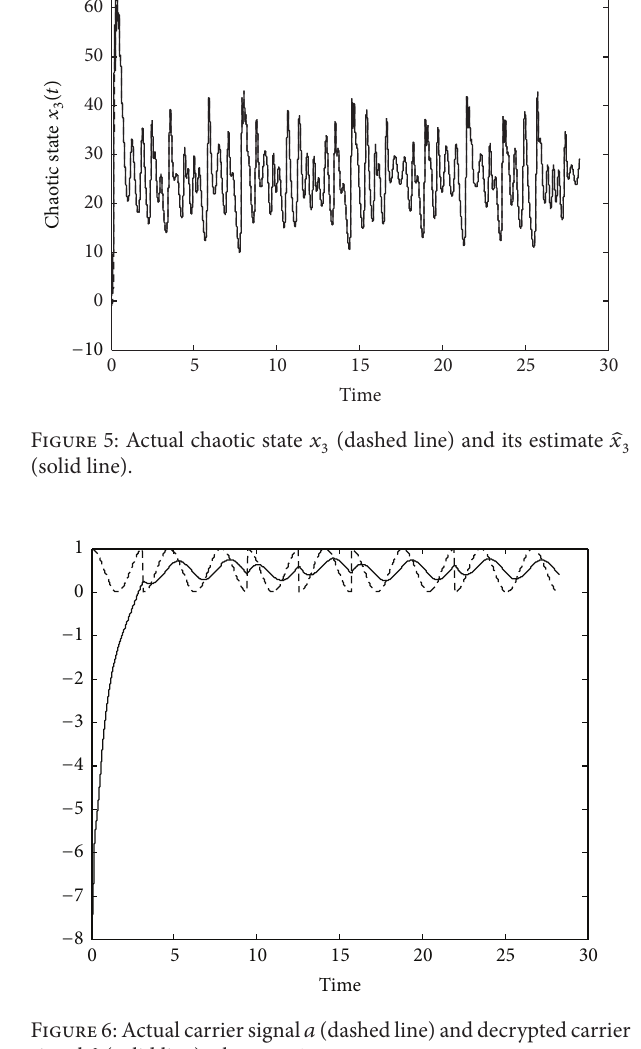
Figure 4: Actual chaotic state 𝑥 2 (dashed line) and its estimate ̂𝑥 2 (solid line).